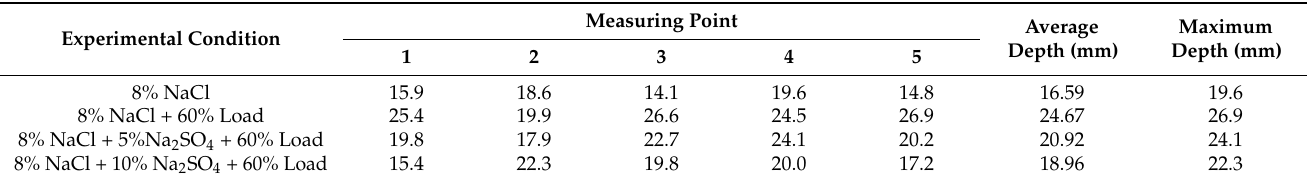
Table 5. The erosion depth of concrete immersed in different sodium sulfate and sodium chloride coupling of the cyclic loading condition.